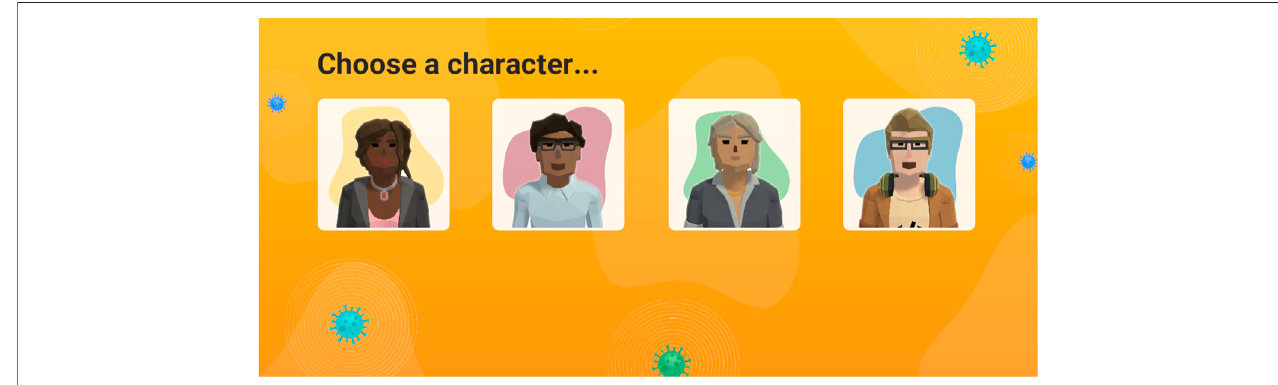
FIGURE 3 | The four avatar types that could be chosen at the beginning of play.